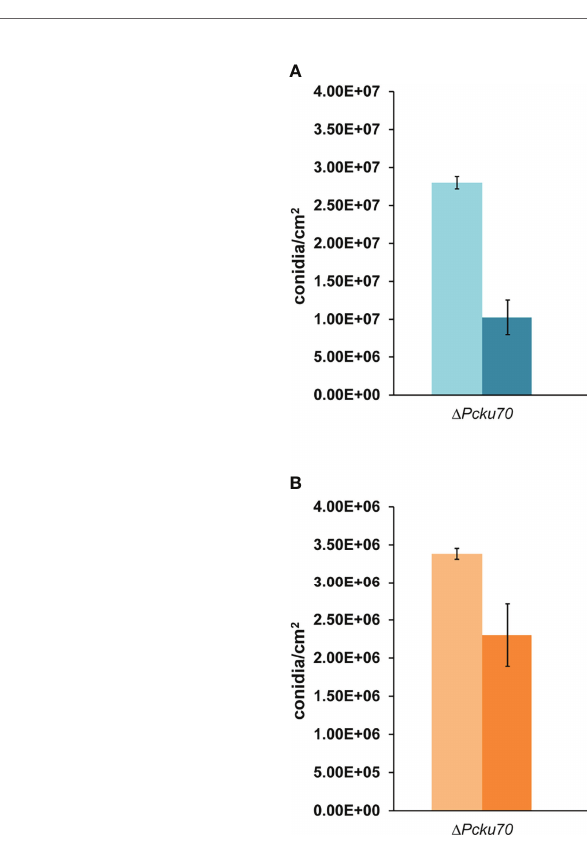
FIGURE 5 | Quantitative assay of conidiation in D tom1 . Quanti fi cation of conidia formation in the recipient D Pc ku70 , the deletion D tom1 and corresponding complementation D tom1::EGFP-Tom1 strains. Strains were grown on solid CCM for 168 h exposed to either constant light or constant dark at 27°C ( A ) and 31°C ( B ) . Light blue/light orange columns represent exposure to light and dark blue/dark orange columns exposure to dark. Error bars indicate representing mean ± SD (n = 3) values for three independent experiments. Statistical analysis was performed using t-tests for comparisons to the control D Pc ku70 strain (***P<0.005, **P <0.05, *P